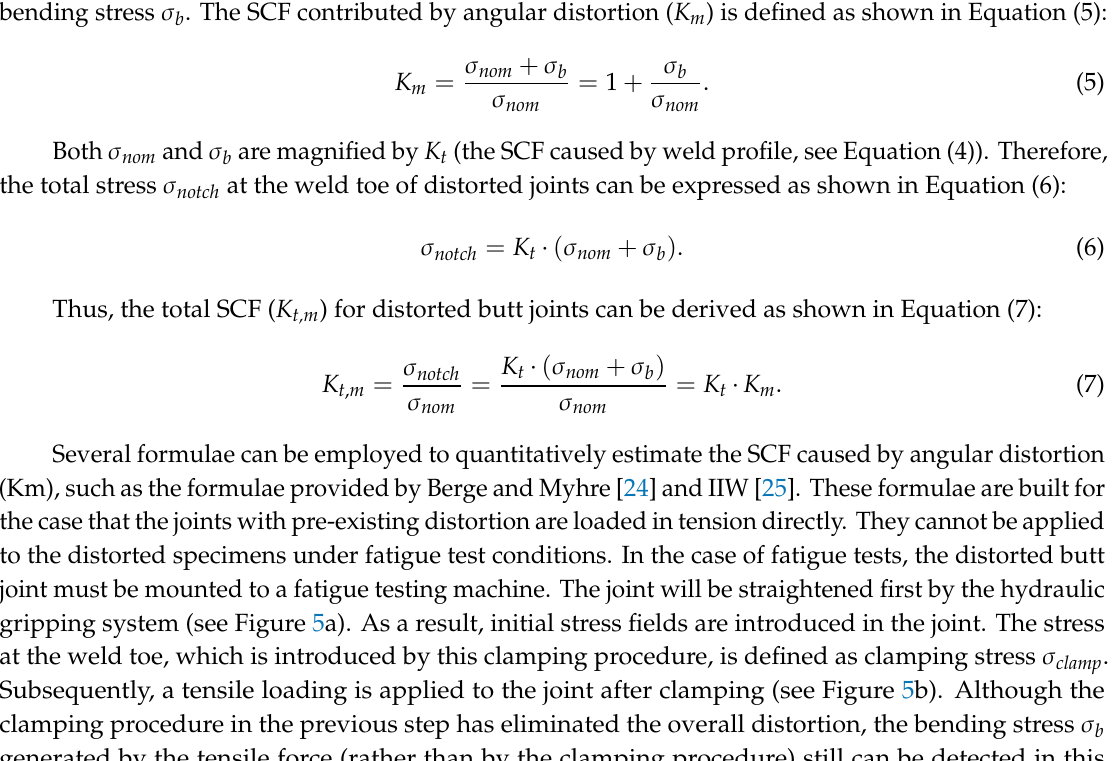
Figure 11. Stress components of the plates with angular misalignment under the axial tension.